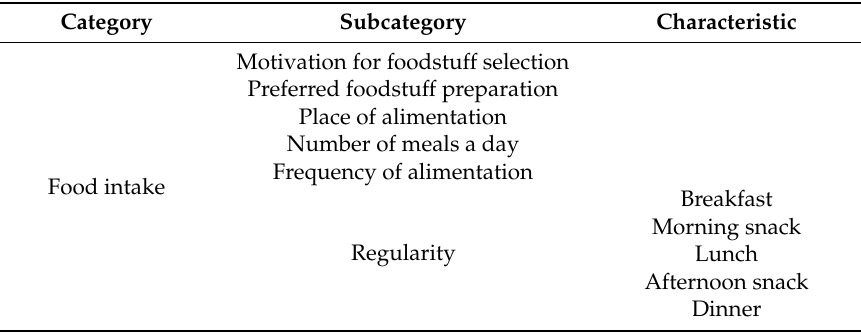
Table 2. Open coding.